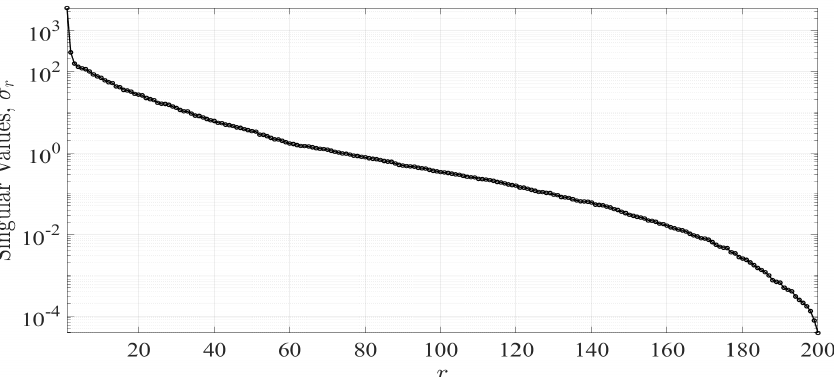
Figure 7. Principal components of the frequency of a Doppler